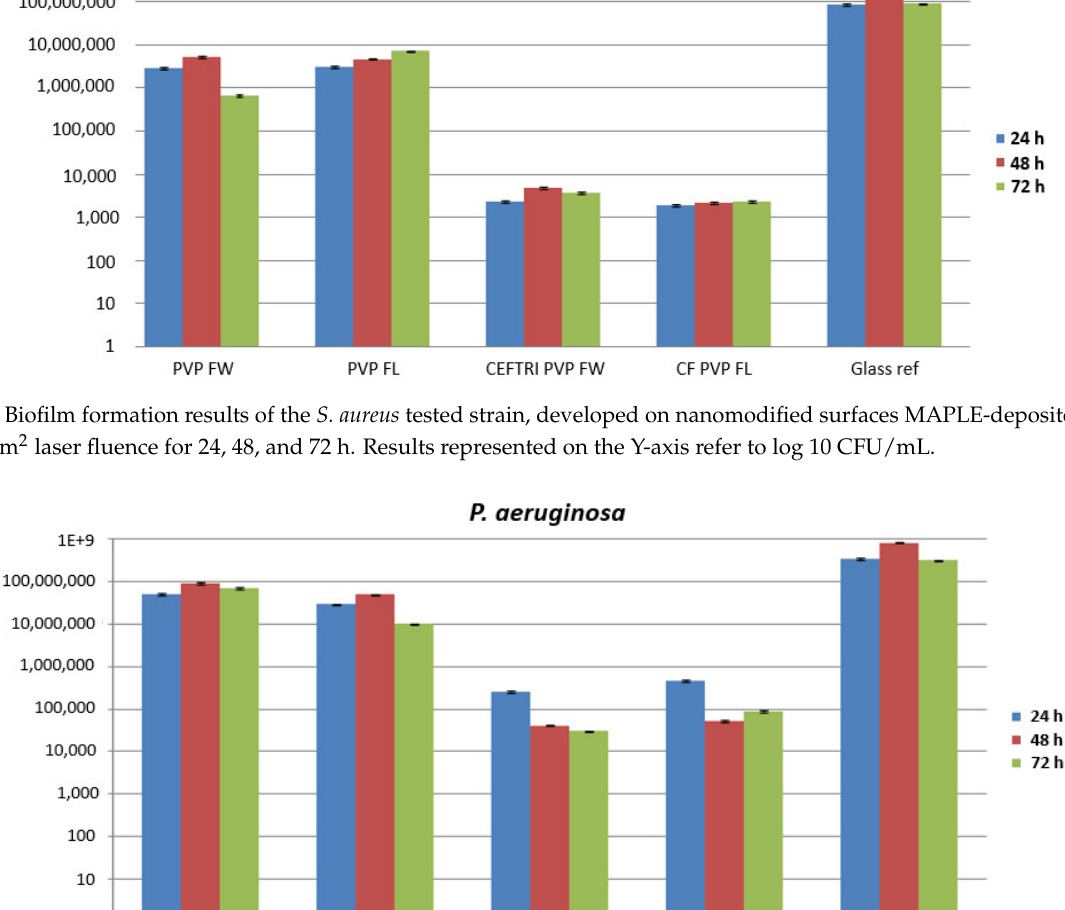
Figure 8. Biofilm formation results of the P. aeruginosa tested strain, developed on nanomodified surfaces MAPLE-deposited at 200 mJ/cm 2 laser fluence for 24, 48, and 72 h. Results represented on the Y-axis refer to log 10 CFU/mL.